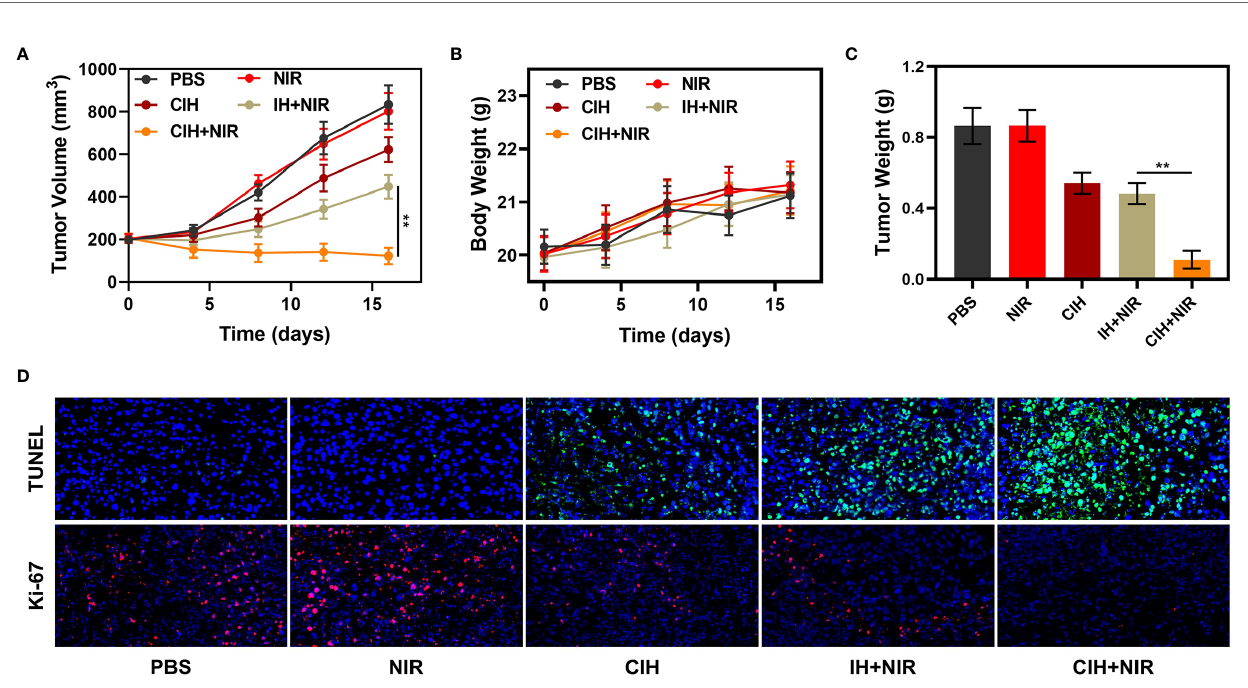
FIGURE 5 | In vivo experiments. (A) Relative changes of tumor volume in mice bearing 4T1 tumors after indicated treatments. (B) Body weight changes of treated mice. (C) Tumor weight measured following the indicated treatments. (D) Representative digital photos of tumors collected from various groups. (D) TUNEL and Ki- 67 tumor sections from the indicated treatment groups. ** P < 0.01; Student ’ s